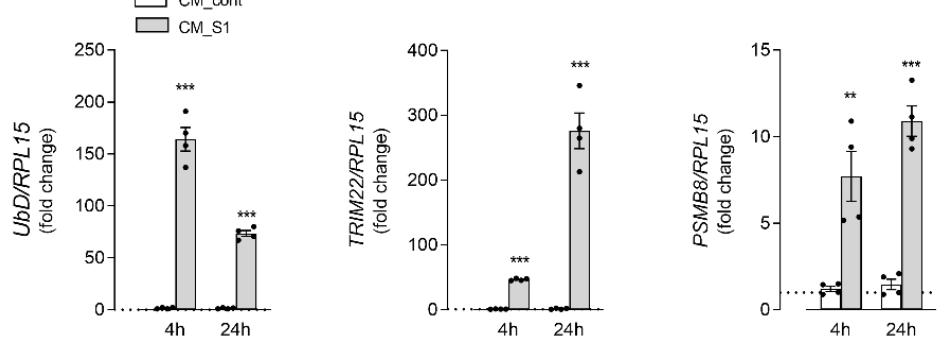
Figure 3. Effects of conditioned medium from S1-treated macrophages on the expression of proteasome-related proteins in alveolar epithelial cells. A549 cells were incubated under the same conditions as in Figure 1. The expression of the indicated genes was measured after 4 or 24 h of incubation by means of RT-qPCR, as described in Methods. The expression of each gene is shown as fold change of the mRNA measured in cells maintained in RPMI (=1, dotted line). Bars are means ± SEM of four independent experiments (single dots), each performed in duplicate. ** p < 0.01, *** p < 0.001 vs. CM_cont with Student’s t -test.